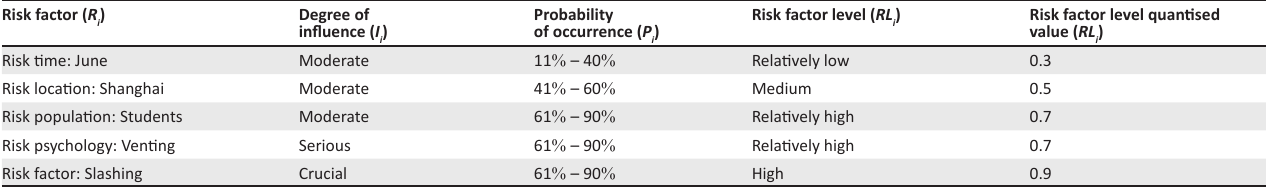
TABLE 5: Risk factor assessment results regarding ‘Shanghai slashing of primary school students’. Risk factor ( R ) i